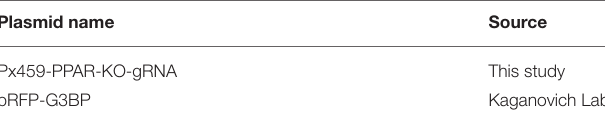
TABLE 1 | Plasmids used in this